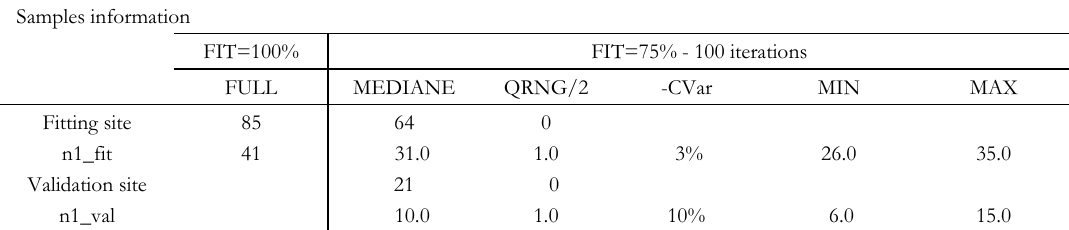
Generic information about the